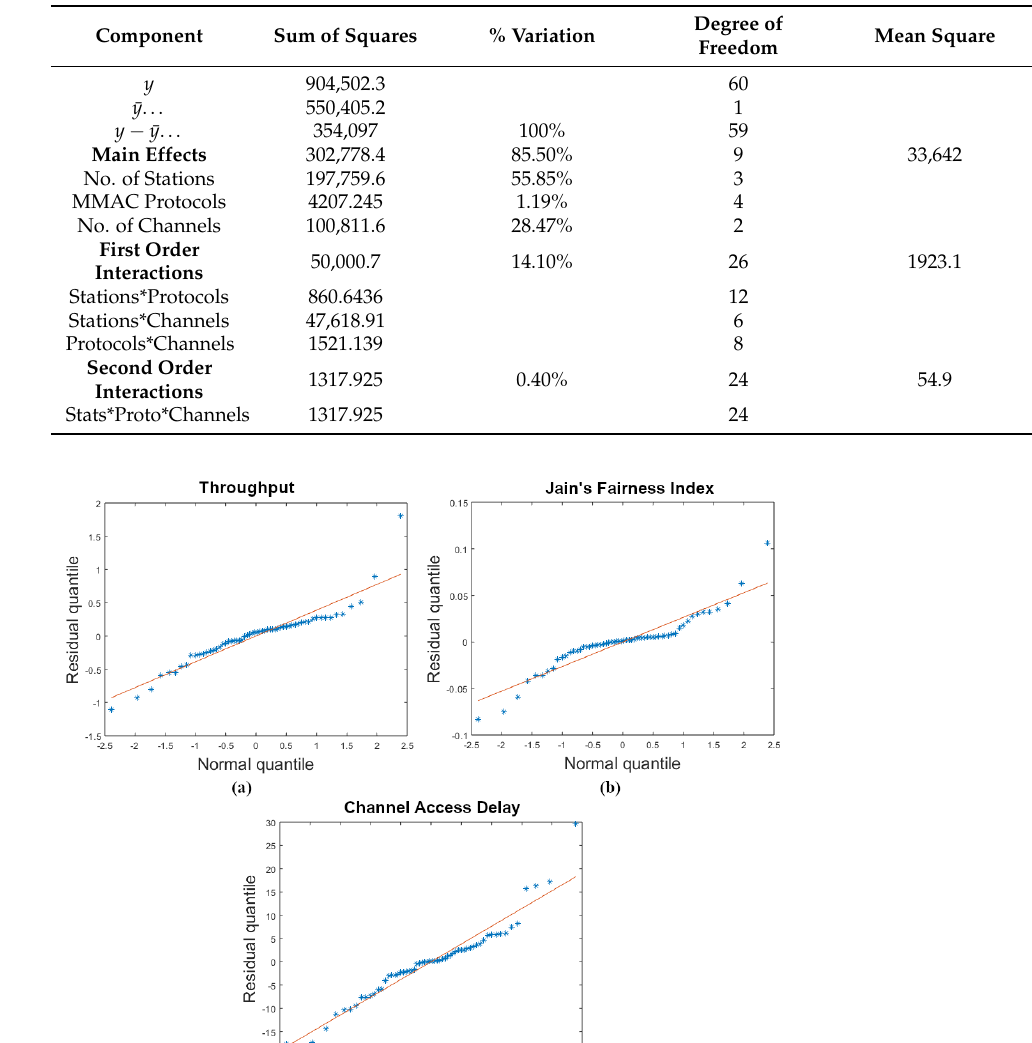
Table 8. ANOVA for Channel Access Delay.